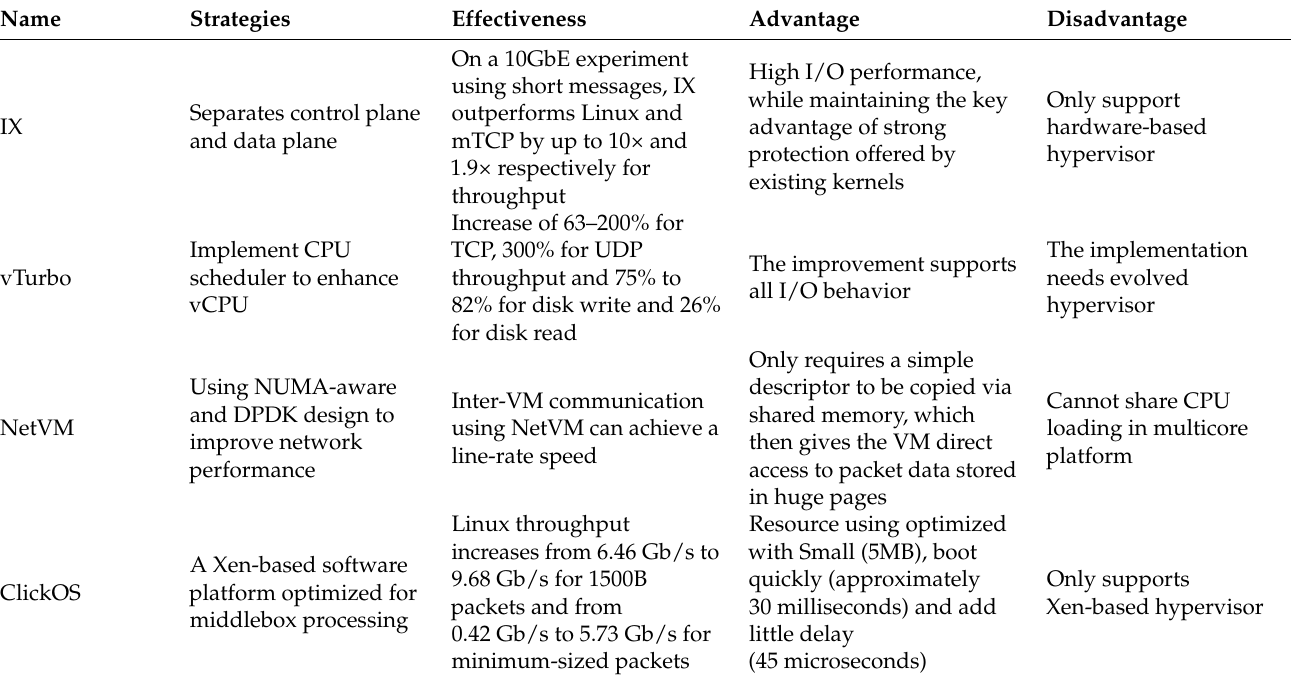
Table 1. Network acceleration in